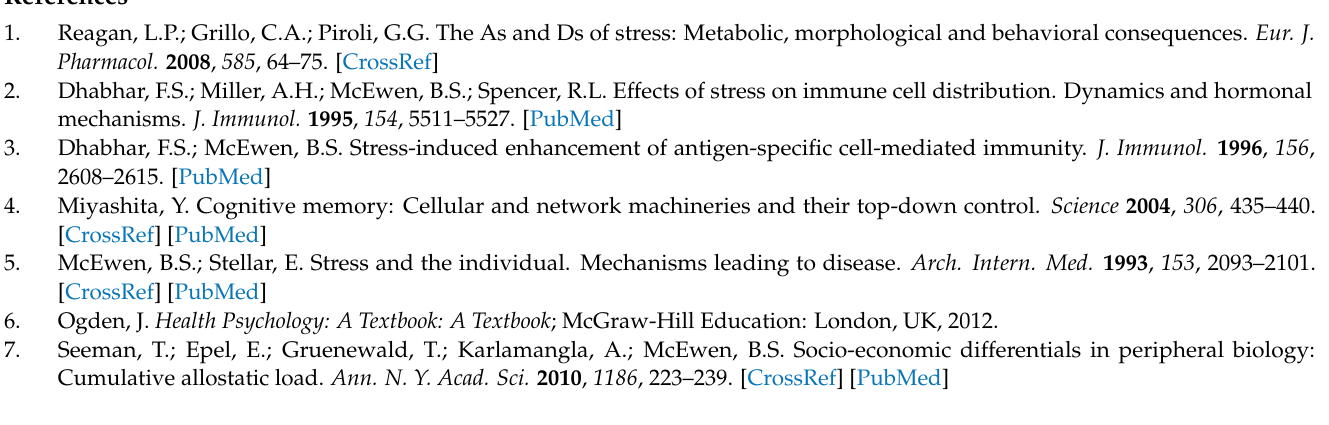
Table S2: Neuroactive ligand-receptor interaction (KEGG: 04080) Pathway Genes, Table S3: ECM- receptor interaction (KEGG: 04512) Pathway Genes, Table S4: Functional enrichment of differences in prostate gene expression between EA and AA subjects, Table S5: 187 Gene Signature differentially expressed between EA and AA subjects, Table S6: Functional enrichment of the 187 Gene Signature, Table S7: cBioPortal analysis of the 187 Gene Signature, Table S8: Univariate differences in patient clinical characteristics, Table S9: Clinical characteristics of the five extremal patients, Figure S1: Analysis of the 187 gene signature using